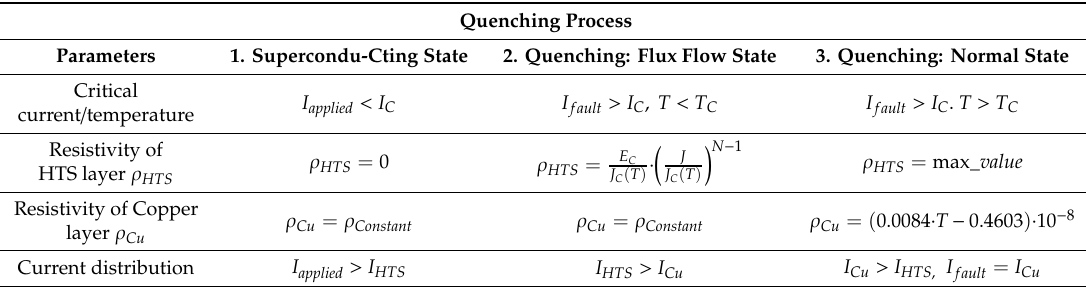
Table 1. Quenching